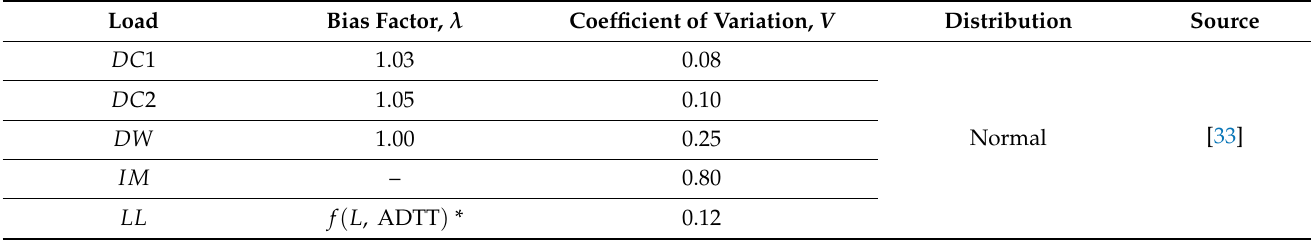
Table 5. Statistical parameters for the load effects (bridge